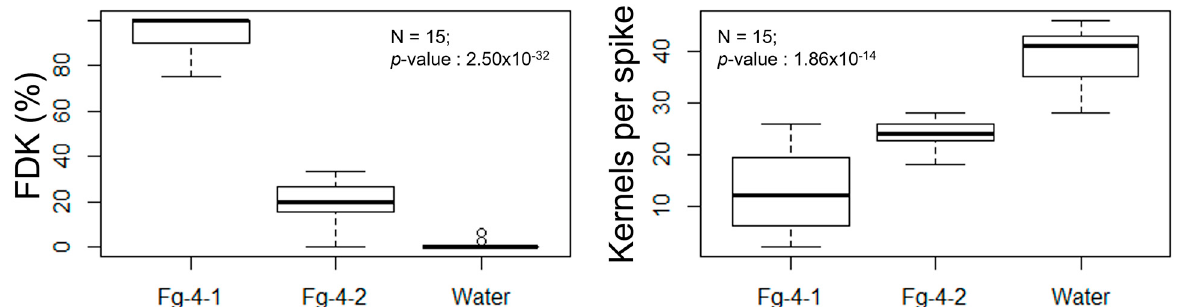
Figure 5. Mean FHB-damaged kernels rates (FDK) ( left ) and total kernels per spike ( right ) after inoculation of wheat NIL-S with F. graminearum isolates Fg-4-1 and Fg-4-2, and sterile water. Virus-free strain Fg-4-1 shows greater numbers of damaged kernels as well as decreased kernel production when inoculated to wheat heads at 7–28 dpi when compared to FgV1-SD4-infected strain Fg-4-2 inoculation and mock water control.